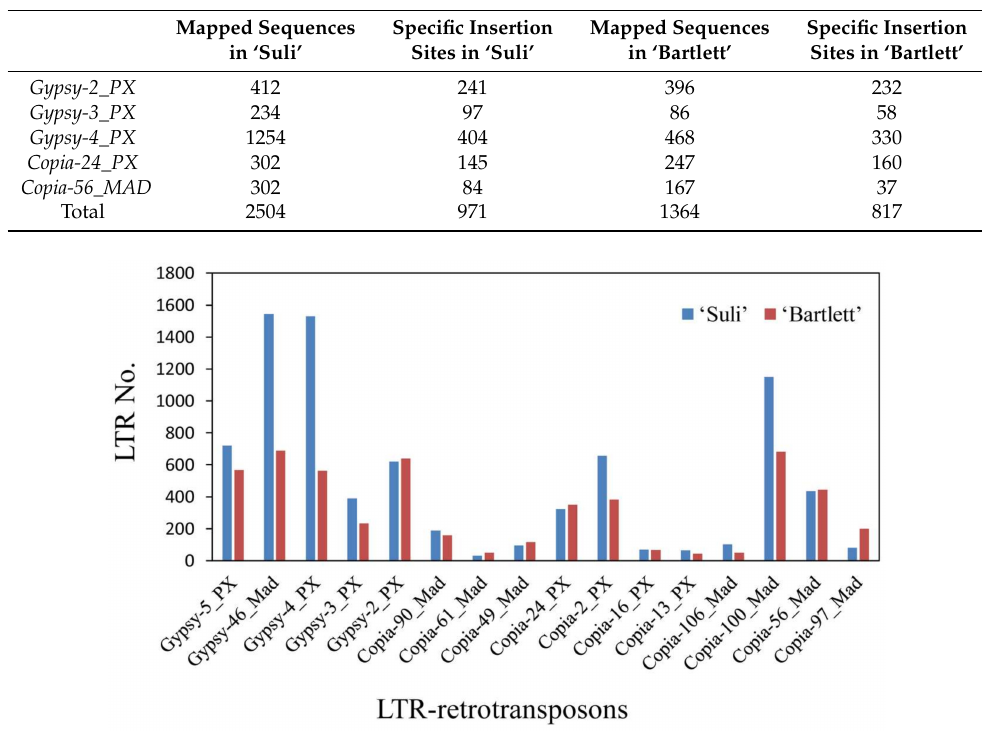
Figure 6. The number of LTR sequences of fourteen isolated LTR-RTs and two other selected LTR-RTs tracked in the ‘Suli’ and ‘Bartlett’